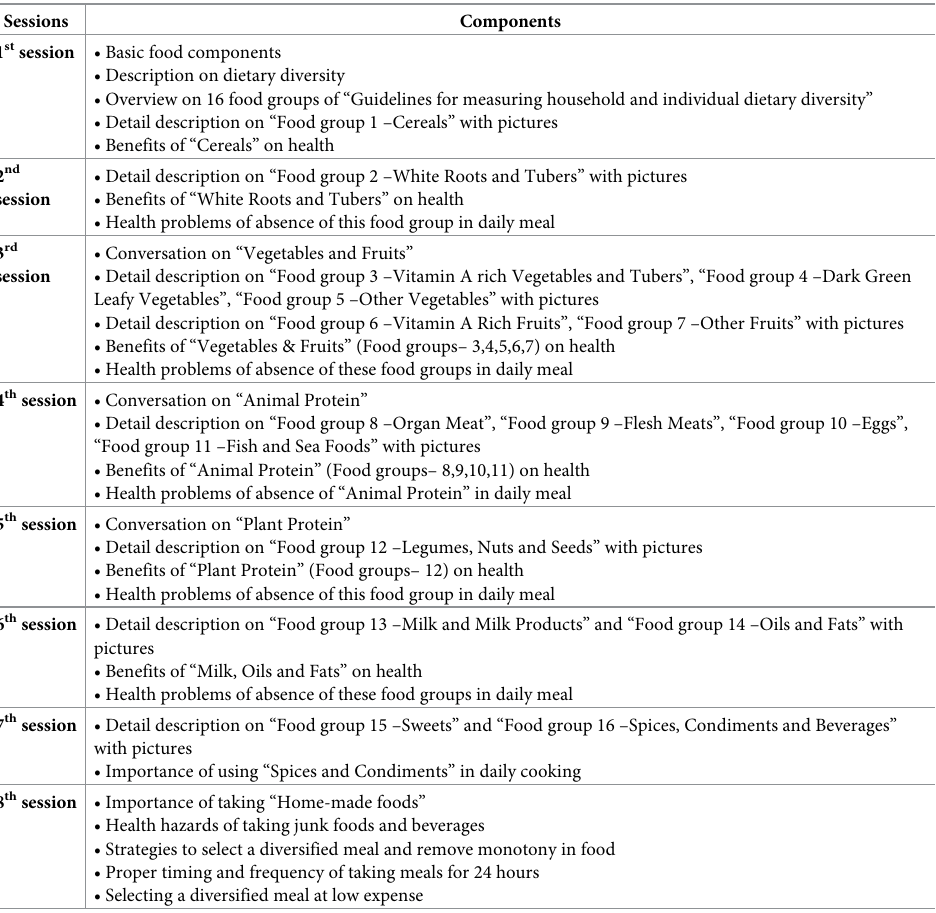
Table 1. Components of our eight education